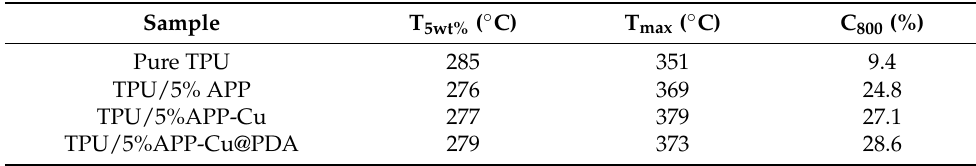
Figure 4. ( a ) TGA and ( b ) DTG curves of pure TPU and TPU composites under N 2 at heating rate of 10 °C/min . Table 2. TGA data for TPU and TPU